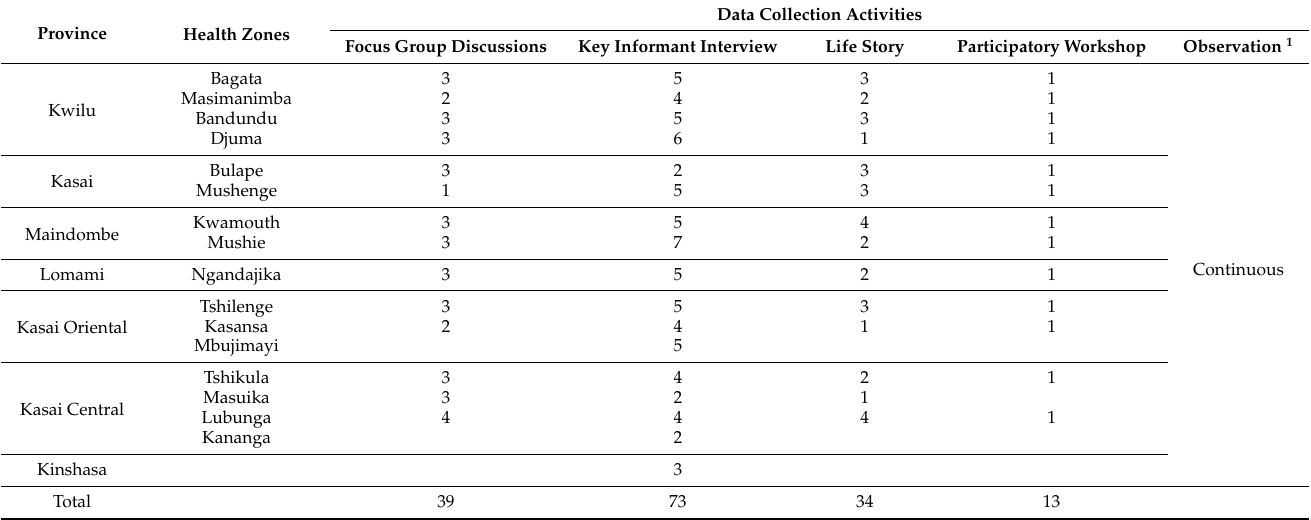
Table 1. Data collection activities and